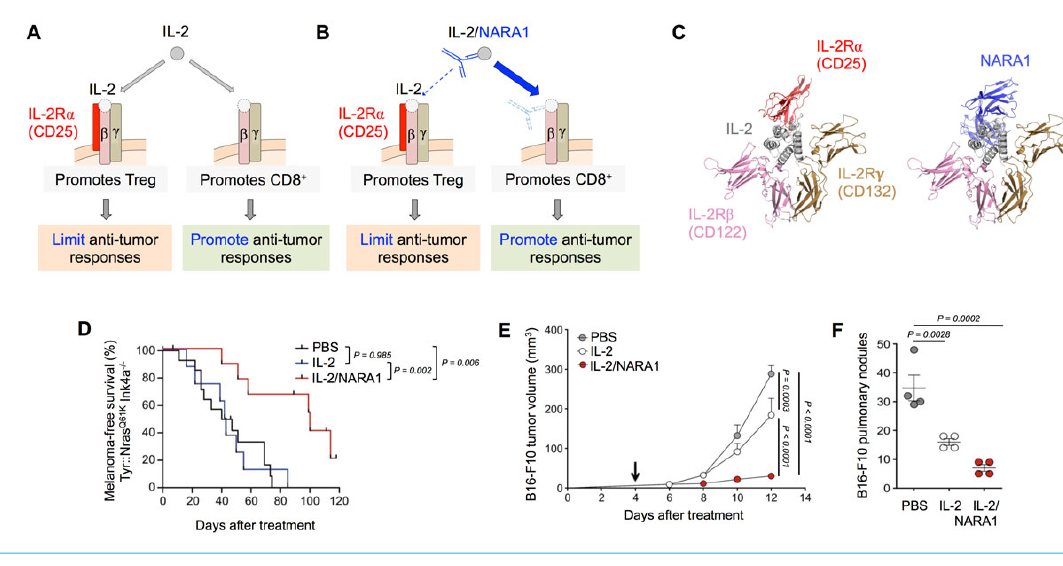
Table 1: CD122-biased IL-2 therapies in development. Human IL-2 (hIL-2)-based formulations that have been reported to show an IL-2 receptor β (CD122) bias, i.e. preference of CD122 over IL-2 receptor α (CD25) binding, are list- ed according to their state of development. Product